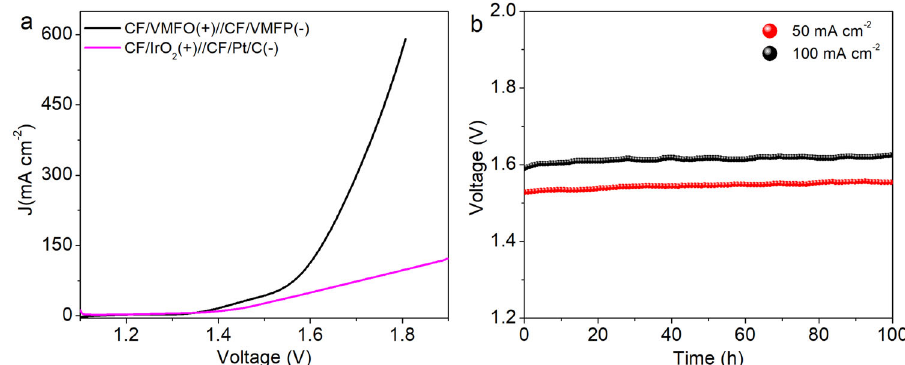
Fig. 8 Overall water splitting activity of the samples in 1 M KOH solution. a Polarization curves of CF/VMFO( + )//CF/VMFP( − ) and CF/IrO 2 //CF/Pt/C at a scan rate of 2 mV s − 1 . b Catalytic stability of CF/VMFO( + )//CF/VMFP( − ) at 50 and 100 mA cm − 2 tested in a two-electrode con fi